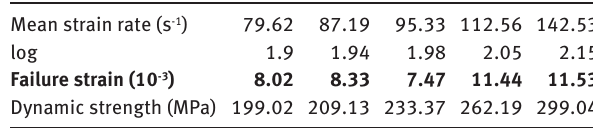
Table 1: The SHPB test results on amphibolites samples (see Figure 3) [38].